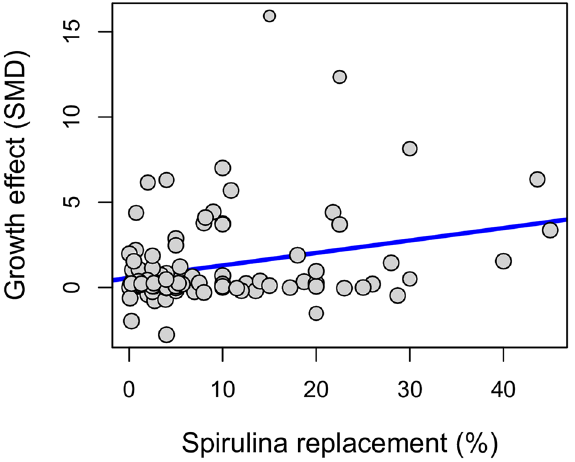
Figure 3. Bubble plot showing the estimated regression slope of the meta-regression on the effect of Spirulina replacement (%) on the Standardized Mean Difference in Specific Growth Rate (%). The size of the points is proportional to the weight of each study.